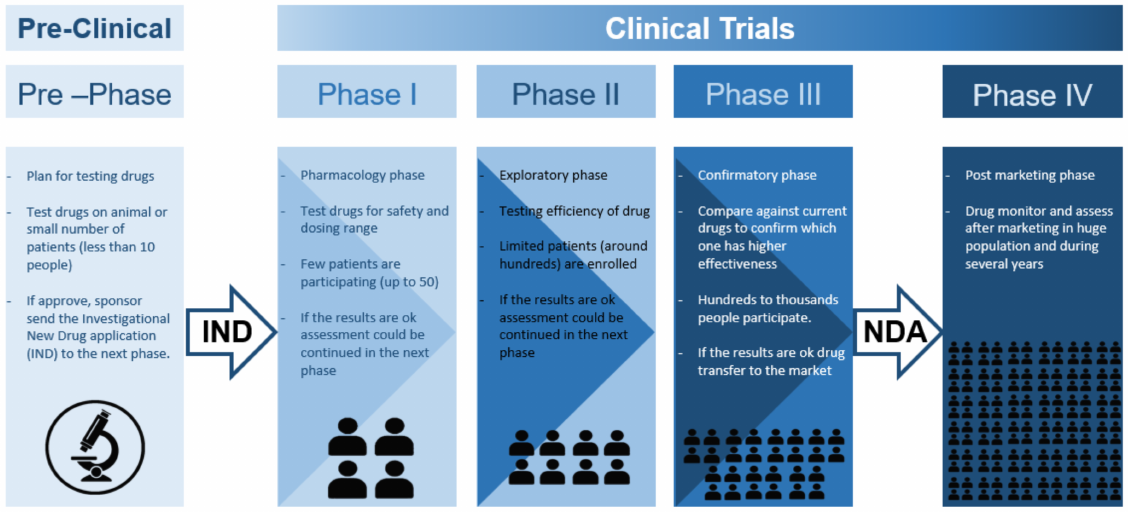
Scheme 1. Illustration of Clinical Trial